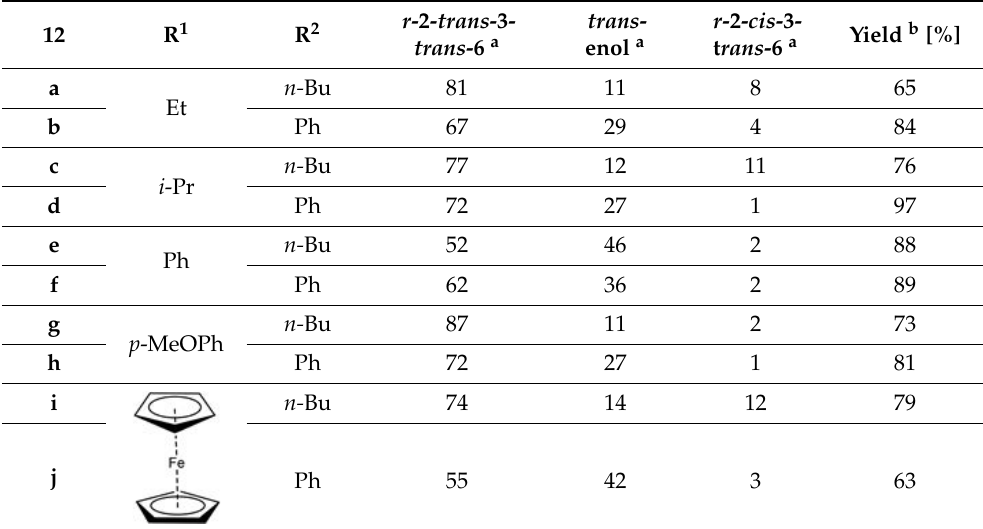
Table 2. Yields and isomers ratio of 6-substituted 2- n -butyl- or 2-phenyl-3- diethoxyphosphoryltetrahydropyran-4-ones 12a–j